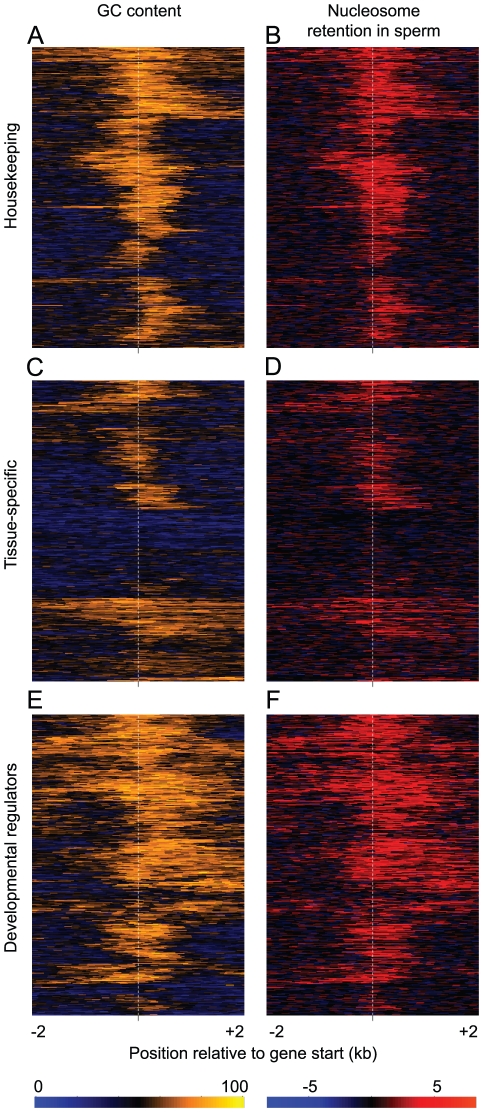
GC-content predicts sperm nucleosome retention at individual genes.GC-content (A,C,E) and sperm nucleosome retention (B,D,F) around the transcription start site of housekeeping genes (A–B), tissue-specific genes (C–D), and transcription factors that regulate development (E–F). Each row of the heat map is an individual gene. Genes are clustered according to their GC-content and the same gene ordering is used in the nucleosome retention plots. In both cases values are calculated in 150 bp windows.